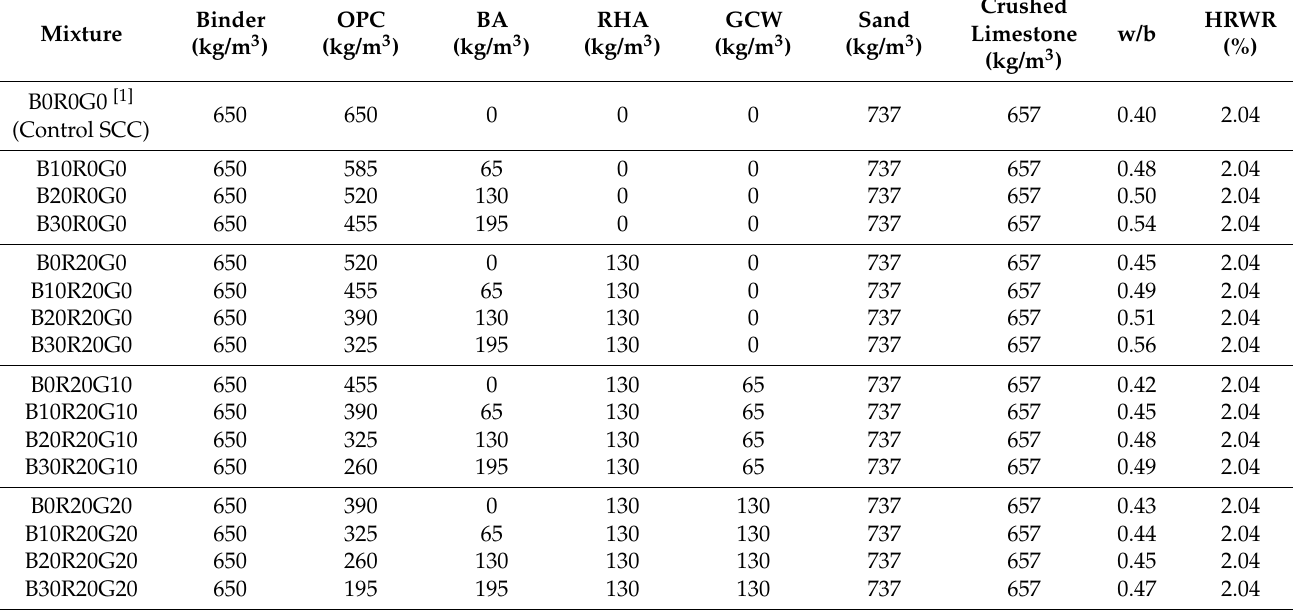
Table 3. Mix proportions of